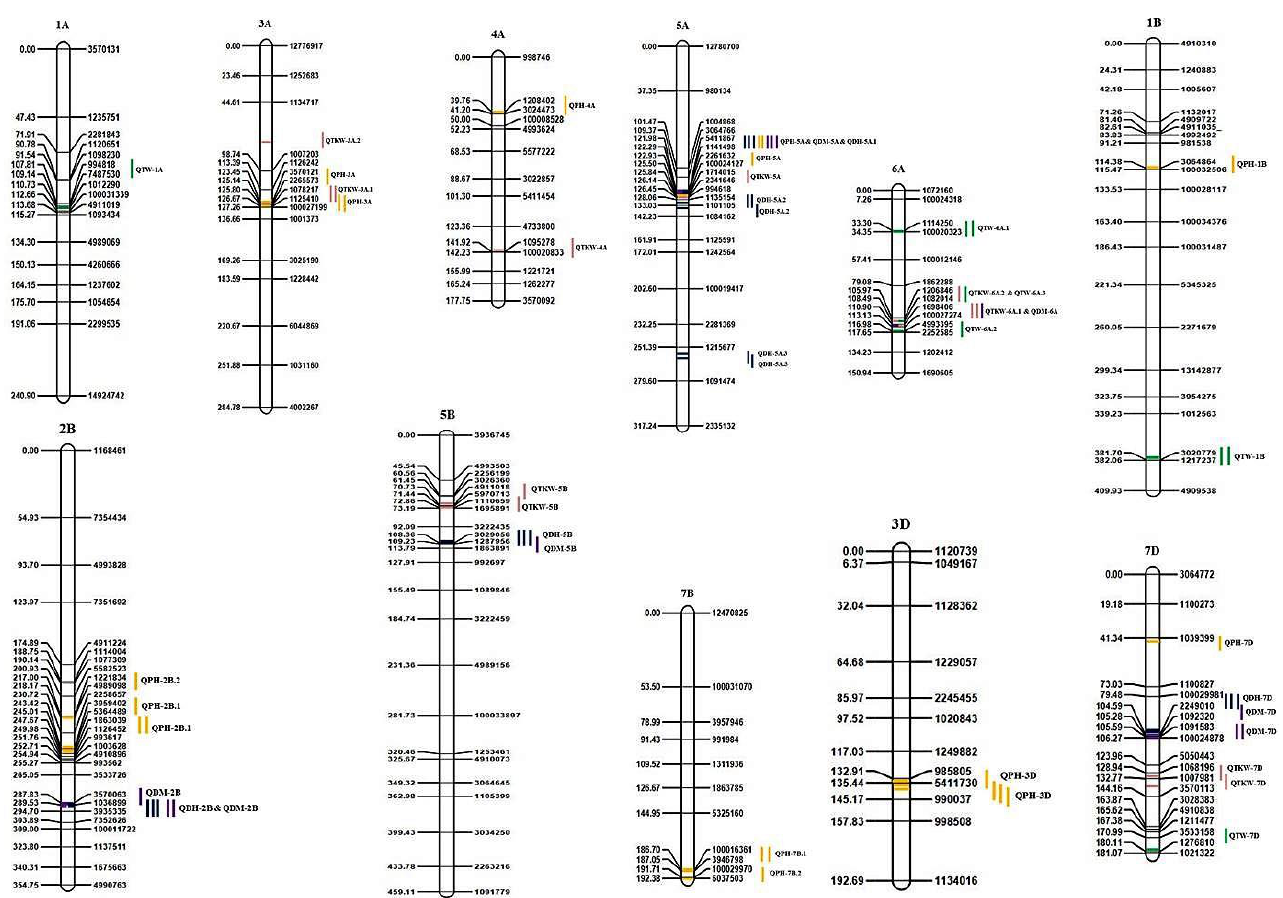
Figure 2. Linkage map and QTLs detected for DH, DM, PH, TKW and TW for 2017 – 2018 (Y1), 2018